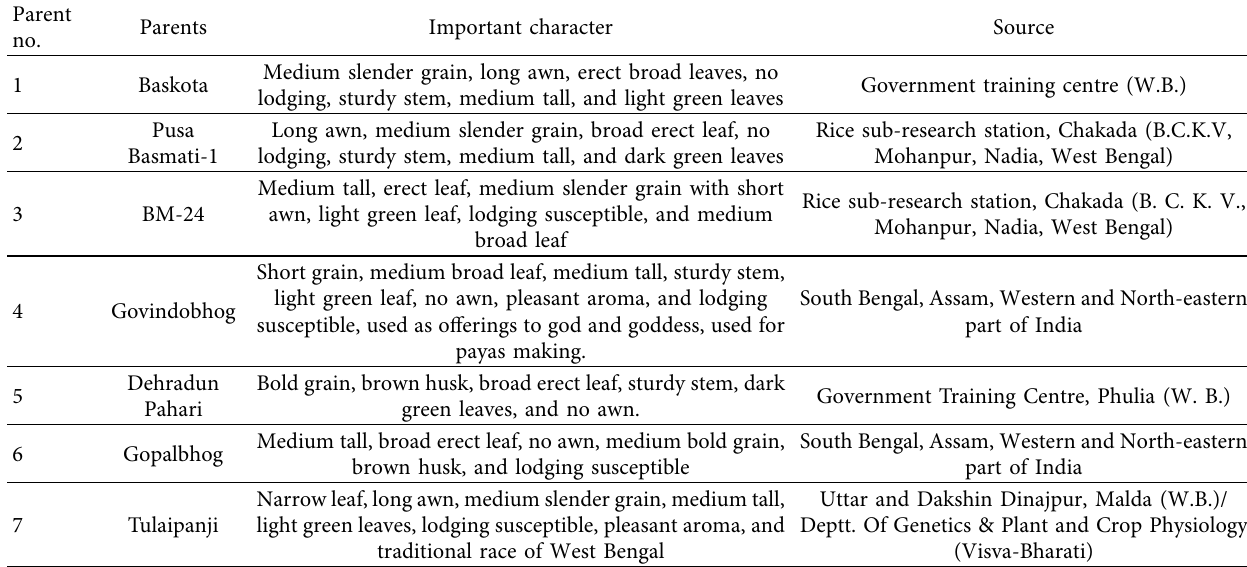
Table 1: List of parents used for crossing programme.